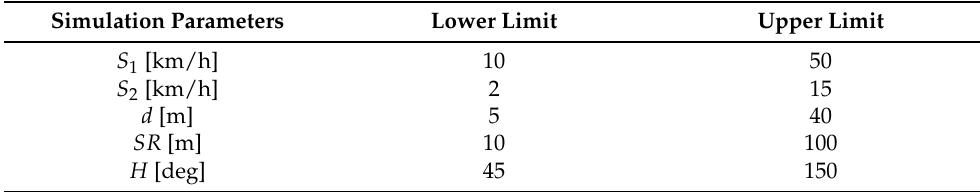
Table 1. Input parameters for the pedestrian step-out scenario and their ranges.